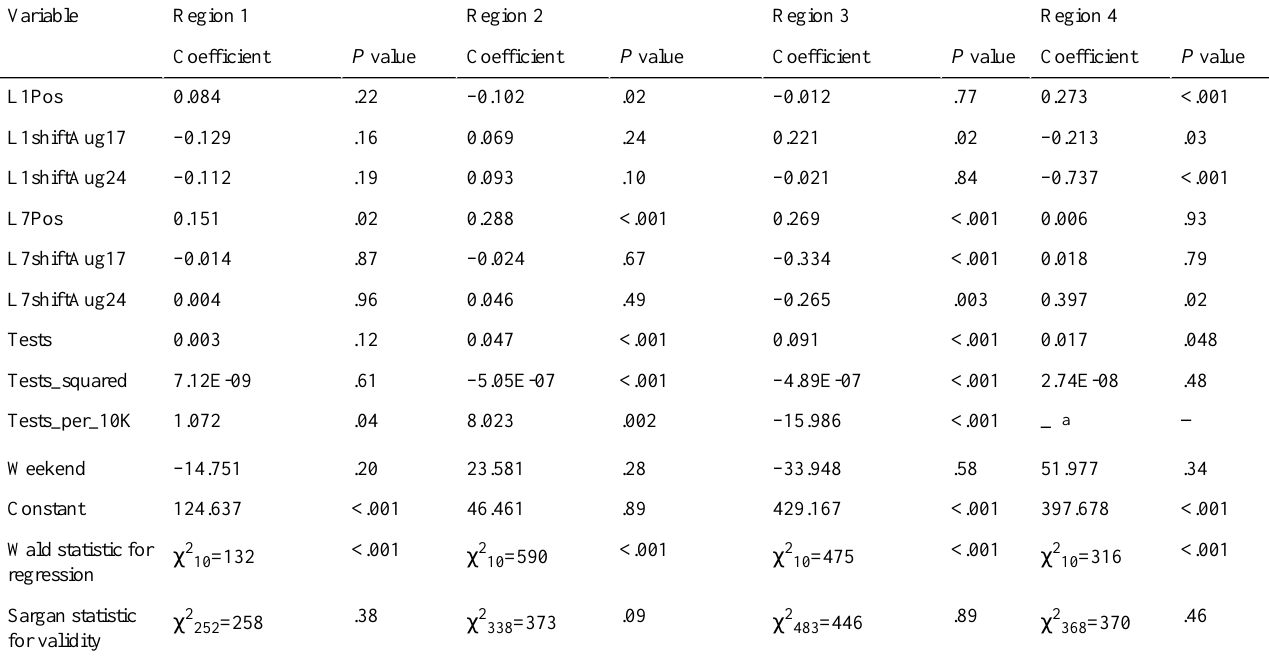
Table 1. Arellano-Bond dynamic panel data modeling of the number of daily infections reported by state, August 2-30,